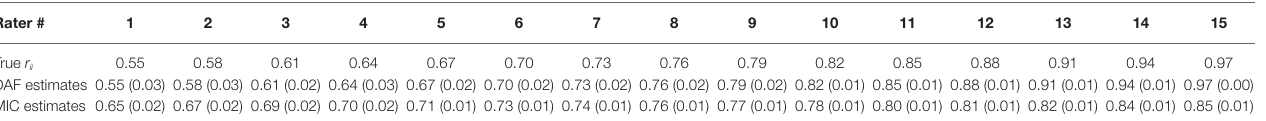
TaBle 4 | Mean reliability estimates and their SEs over 100 replications (SEs in parentheses). rater